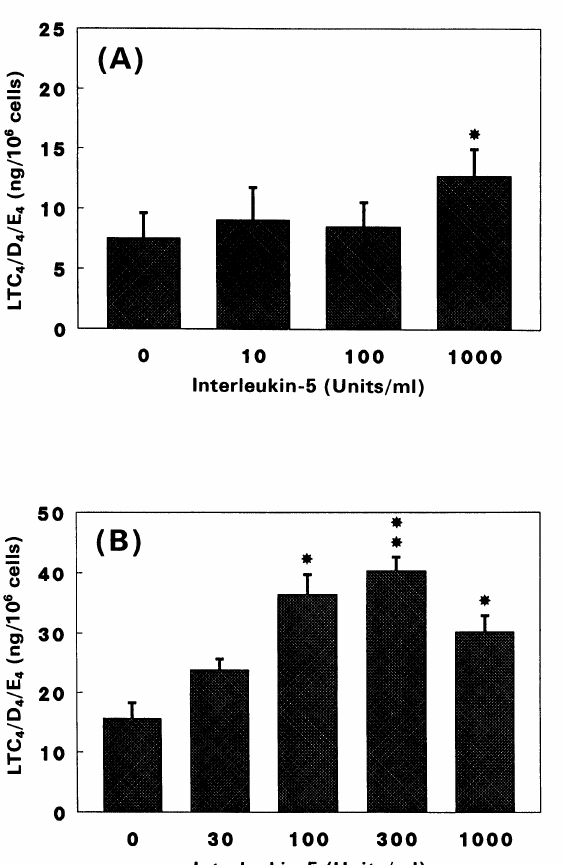
FIG. 1. The effect of different concentrations of L-5 on human eosinophil leukotriene C4/D4/E4 synthesis induced with (A) STZ (n 11) or (B) calcium ionophore A23187 (n 4). Results are presented as means-I- S.E.M. IL-5 and the stimulating agents were added simultaneously. *p < 0.05 and **p < 0.01 as determined with the paired Student’s t-test and compared with the leukotriene synthesis in the absence of IL-5.